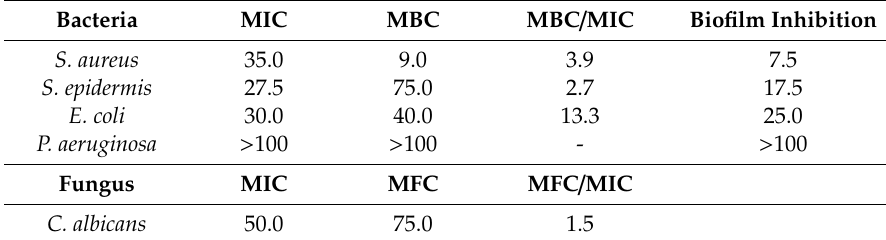
Table 3. MIC, MBC and MFC of VE-TPGS CHX formulation #